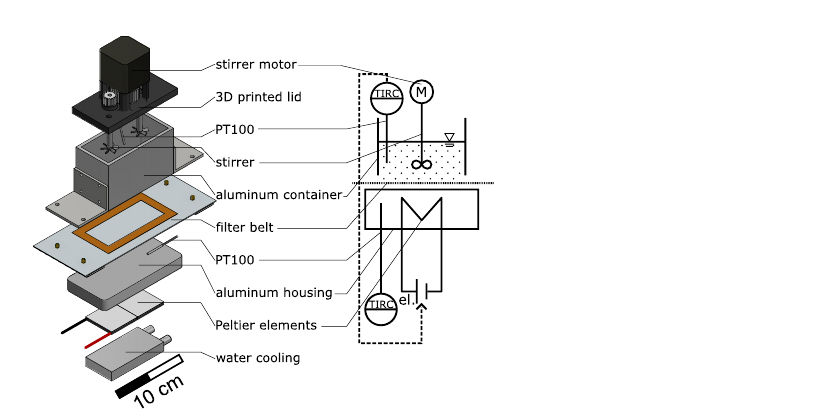
Figure 3. Exploded CAD and schematic view of the process medium container positioned on the temperature control